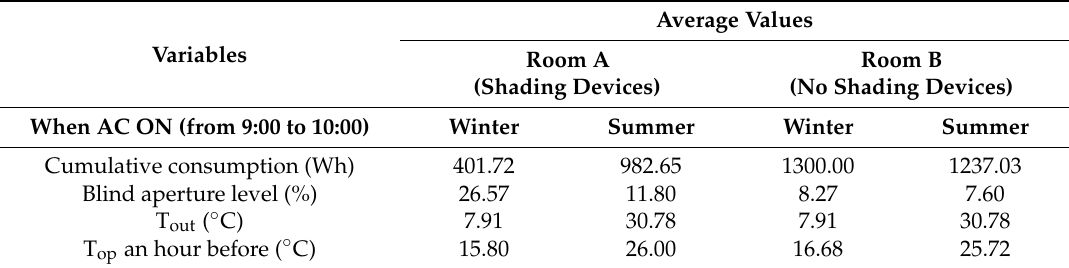
Table 8. Analysis of average values (Wh, Blind level, Tout, and Top) when both classrooms simultaneously recorded air conditioning consumption, during the first hour of class (9:00 to 10:00).